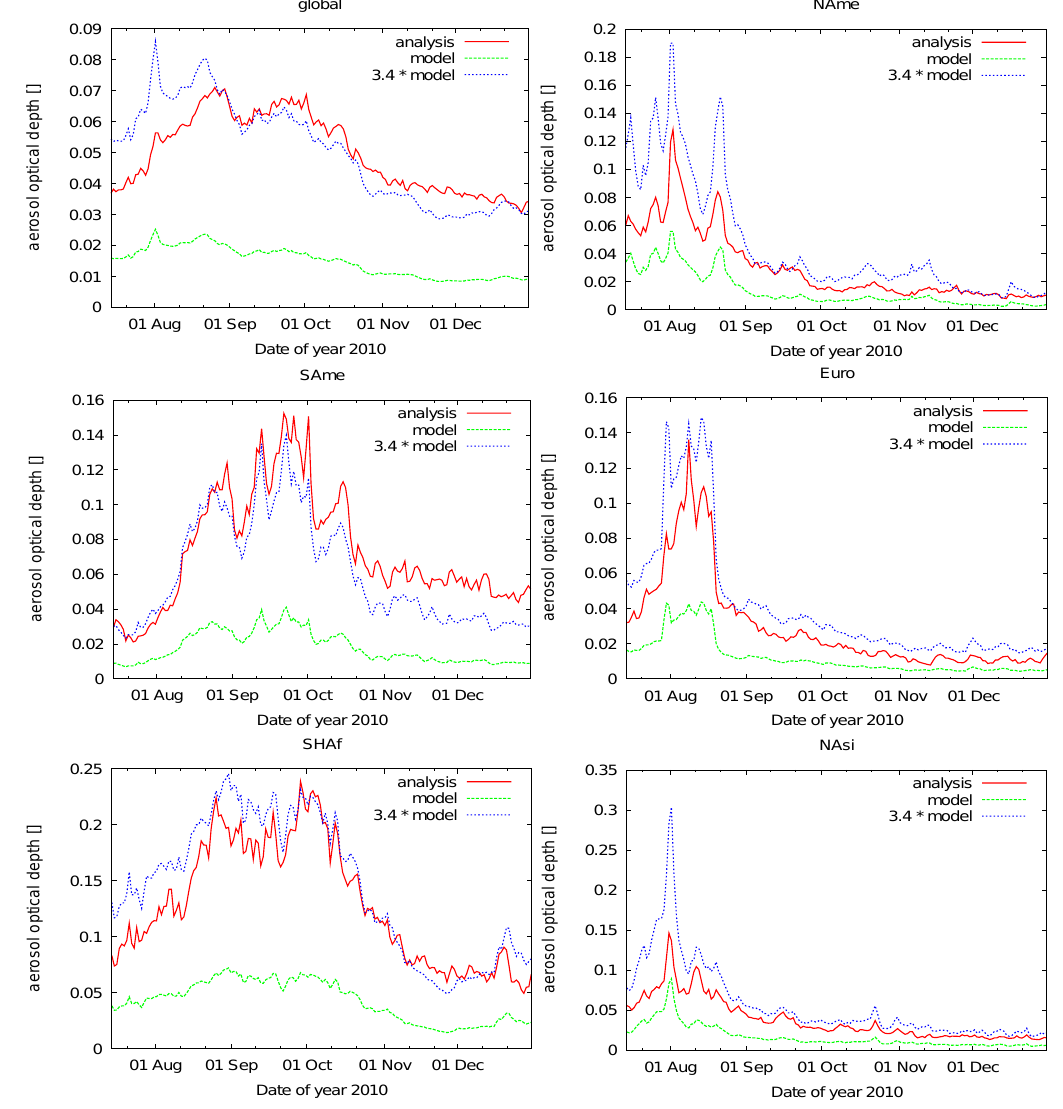
Fig. 9. Daily sums of the average aerosol optical depths (AODs) at 550nm of black carbon and organic matter (OM+BC) during 15July– 31December 2010 in the analysis, the model and the model enhanced by a factor